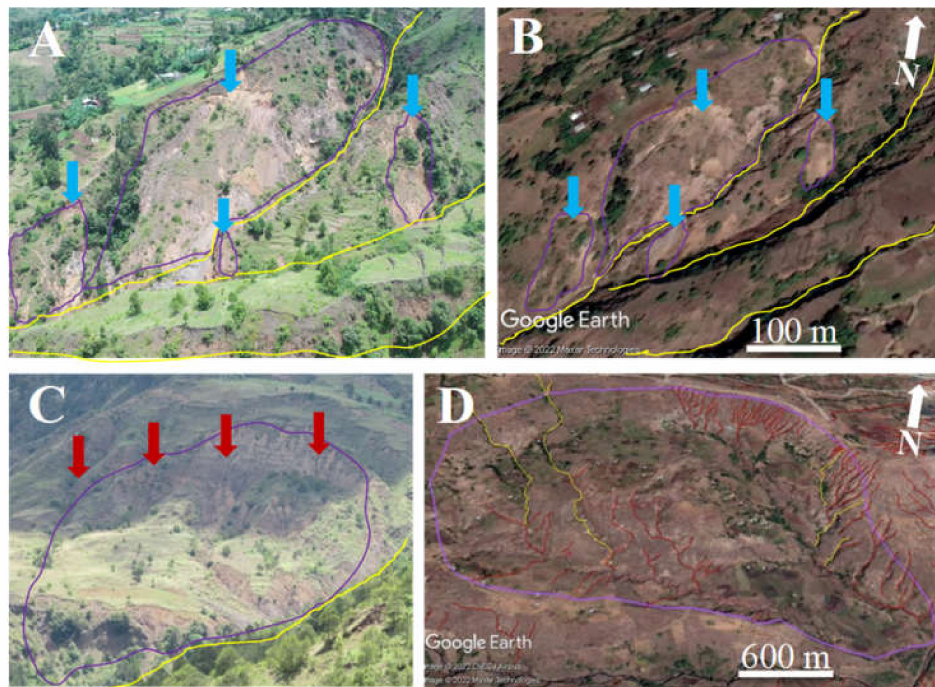
Figure 4. Examples of landslide-gully interactions from Shafe. ( A ) Field observation of active landslides developed from a gully bank (18 September 2021). ( B ) Landslides along gully bank (same place as ( A ) mapped from Google Earth imagery (6 ◦ 19 (cid:48) 2.27 (cid:48)(cid:48) N, 37 ◦ 38 (cid:48) 22.32 (cid:48)(cid:48) E). ( C ) Field observation of inactive landslide (5 May 2018). The red arrows represent the heads of major active and partially active gullies within the landslide. ( D ) Active and partially active gullies developed in a large old inactive landslide mapped from Google Earth imagery (6 ◦ 21 (cid:48) 30.64 (cid:48)(cid:48) N, 37 ◦ 38 (cid:48) 41.52 (cid:48)(cid:48) E). Gullies connected to the rivers can be observed ( C , D ). Most of these gullies are active, they can transport significant amount of soil to the lowlands during intense rainfalls. Landslide head scarps (blue arrows); active gullies (in red); partially active gullies (in yellow); landslides (in